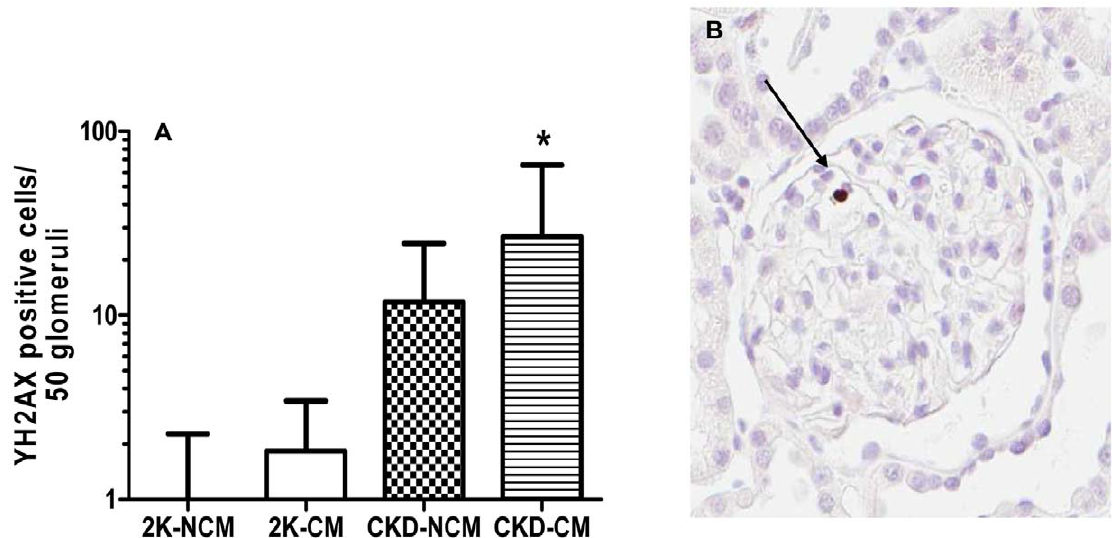
Figure 5. CM treatment increased DNA damage repair. After logarithmic transformation, more c -H2AX positive cells, indicating glomerular nuclei undergoing DNA damage repair, were found after CM treatment in CKD (A). Black arrow indicates positive nucleus (B). 2K-NCM (n=6); 2K-CM